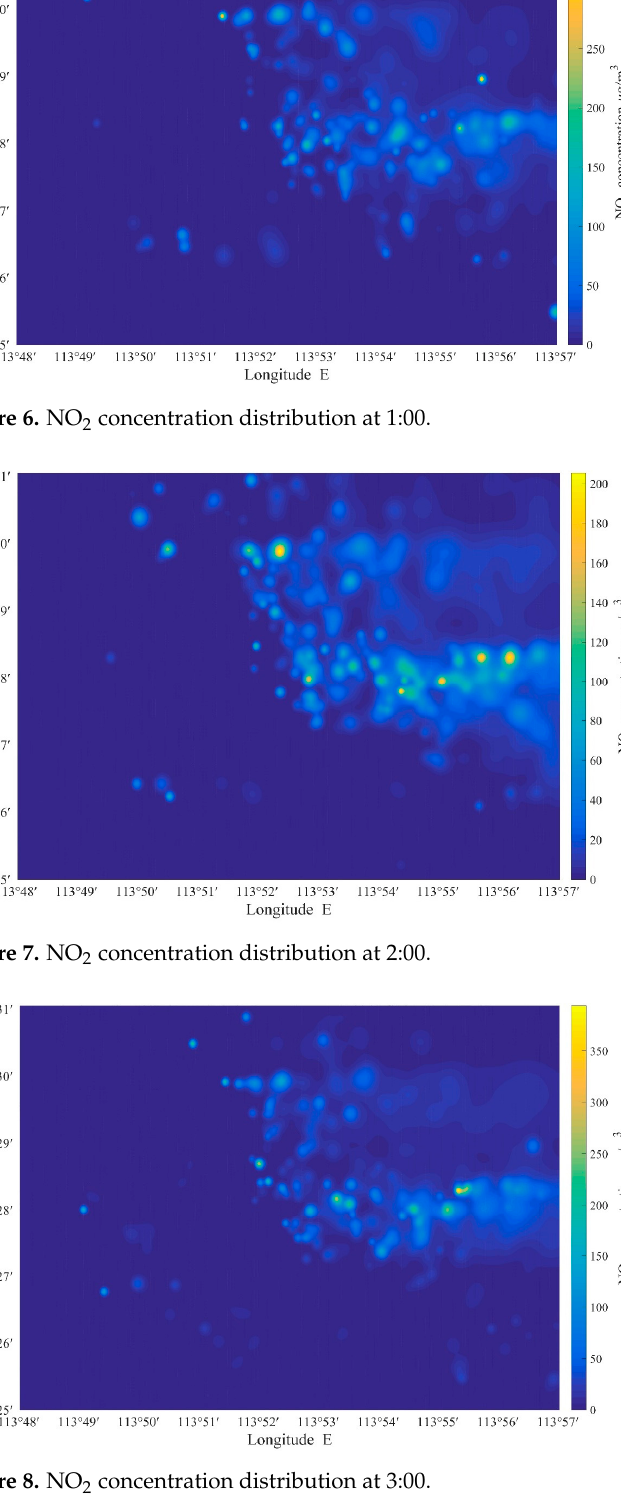
Figure 8. NO 2 concentration distribution at 3:00.